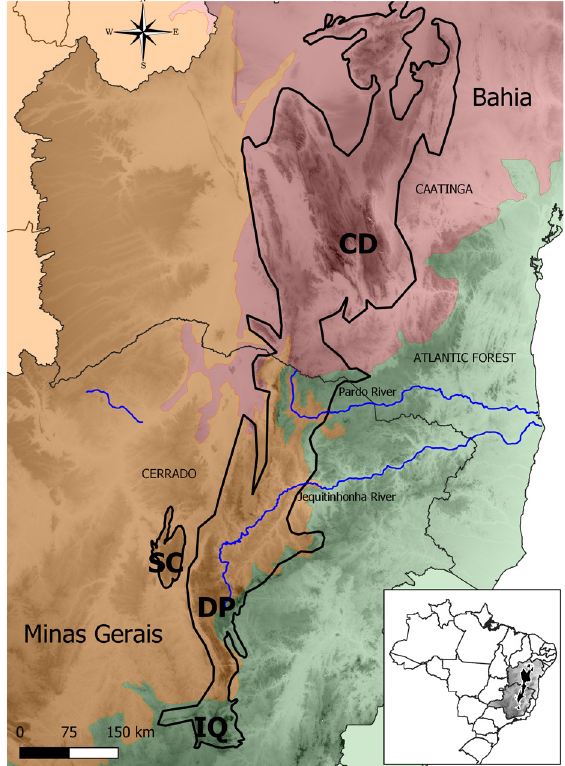
Figure 1. Location map of the Espinhaço Range extending north-south in the states of Bahia (BA) and Minas Gerais (MG). (CD = Chapada Diamantina; DP = Diamantina Plateau; SC = Serra do Cabral; IQ = Iron